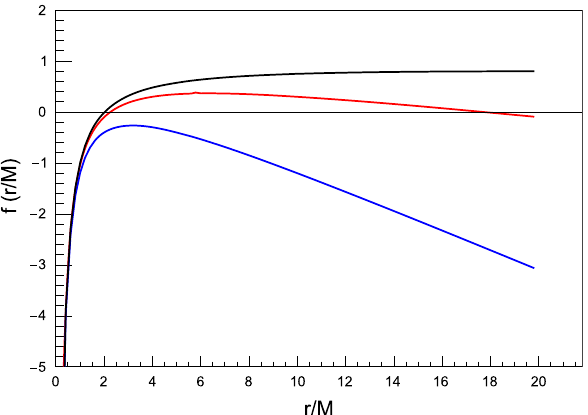
Fig. 2 Ratio of total energy deposition ˙ Q for ω = − 0 . 9 to total New- tonian energy deposition ˙ Q Newt for two values of the parameter c . The green curve shows the GR energy deposition for comparison